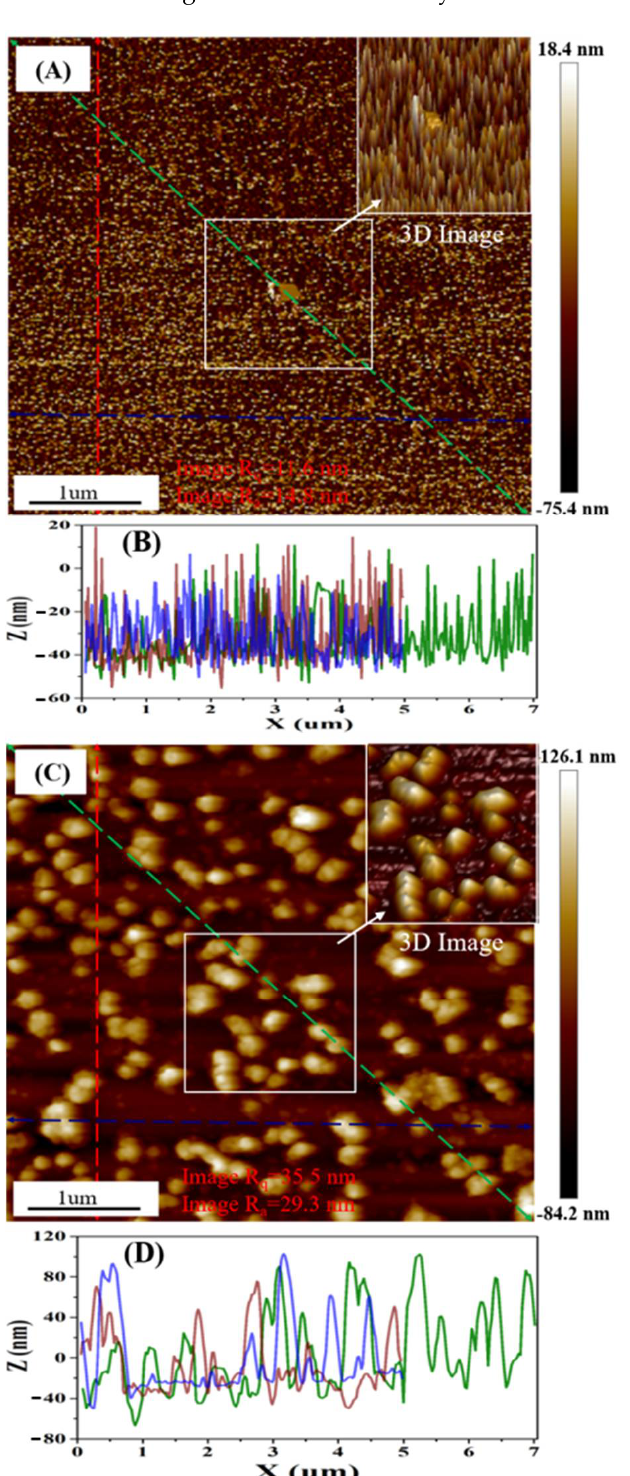
Figure 6. ( A , C ) AFM images of low vacuum pyrolysis film (15 °C/min) and conventional pyrolysis film (0.5 °C/min). ( B , D ) The horizontal, vertical, and diagonal height curves are plotted in blue, red, and green lines.